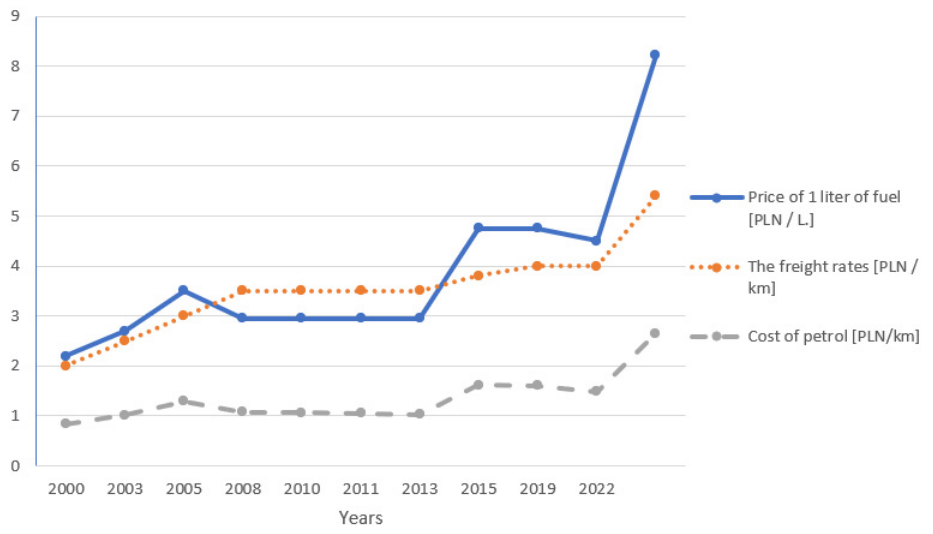
Figure 3. Changes of costs of petrol and freight rates in road transport (HDV) in Poland (2000–2022).